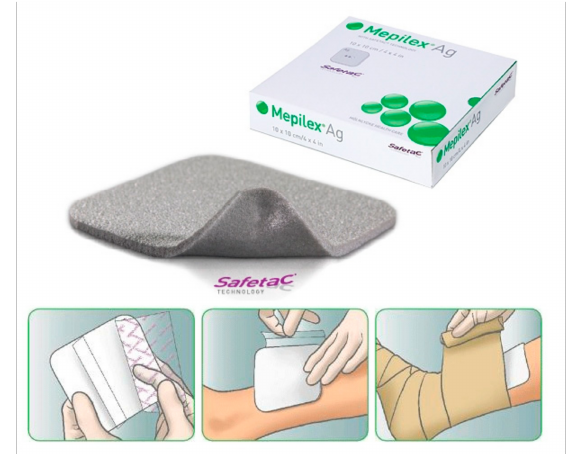
Figure 2. Mepilex ® Ag with instructions for application . Images used with permission of Mölnlycke Health care,